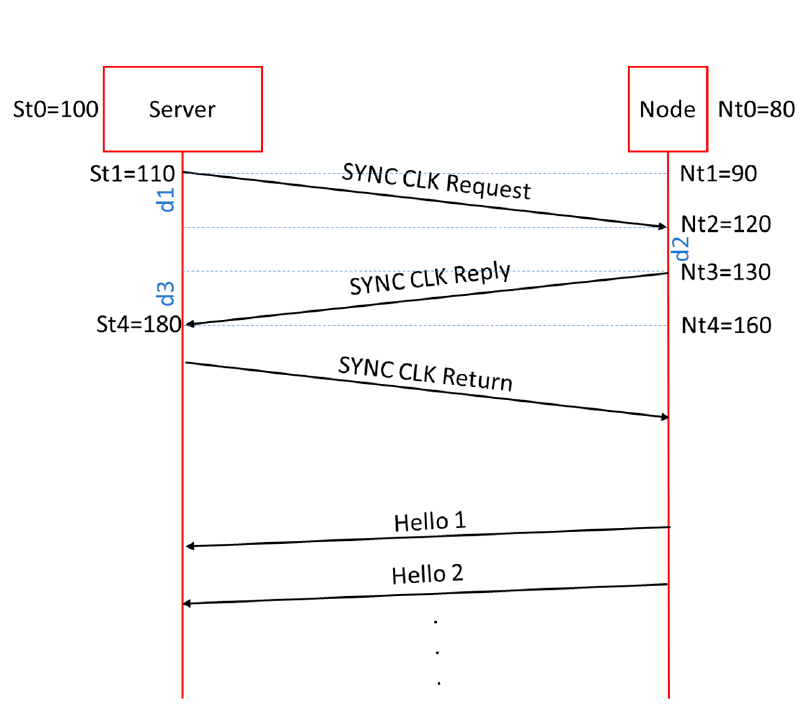
Figure 9. Sequence of synchronization between RPI Server and one Node.